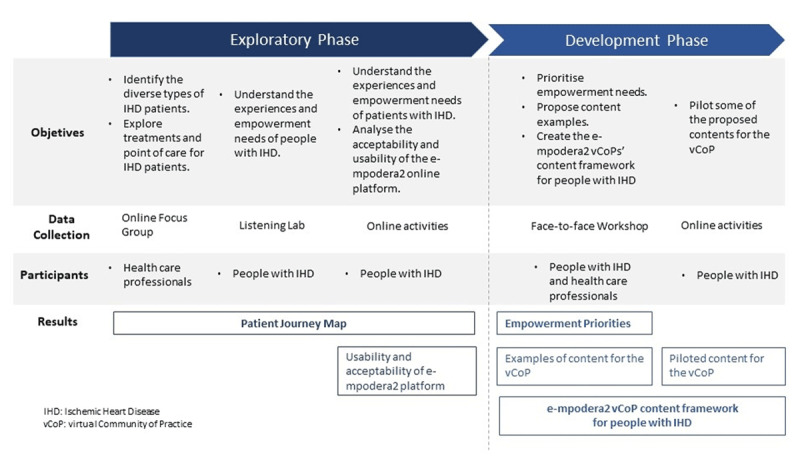
Co-design process.